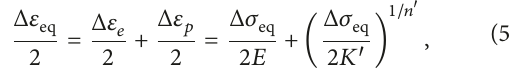
unchanged during the earthquake, which means the angles 𝜃 and 𝜙 are constant, while, for the nonproportional condition, the critical plane varies, and so the angles 𝜃 and 𝜙 also